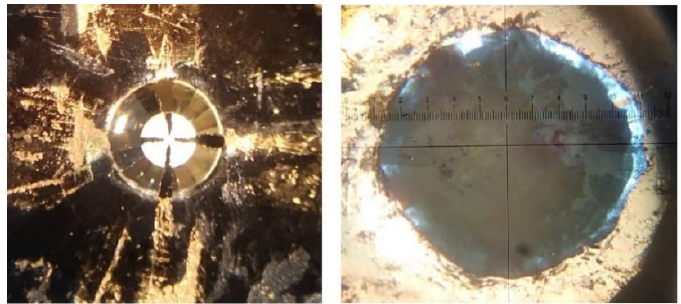
Figure 13. On the left: Diamond with gold sputtered contacts (no sample). On the right: IBN sample within a gasket hole at 5 GPa. The PVC layer is seen in the transparent light blue areas between the inner gasket hole and sample.